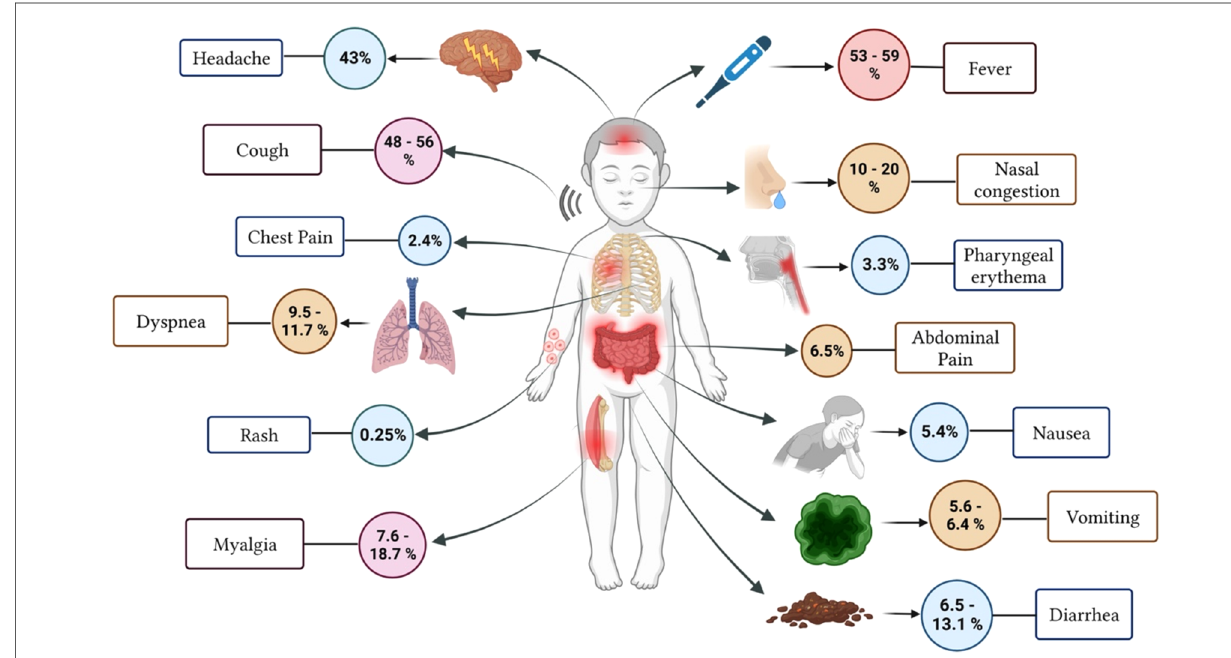
Figure 1 Estimated frequency of Symptoms of COVID-19 infection in pediatric patients (Adapted from Borelli et al.,